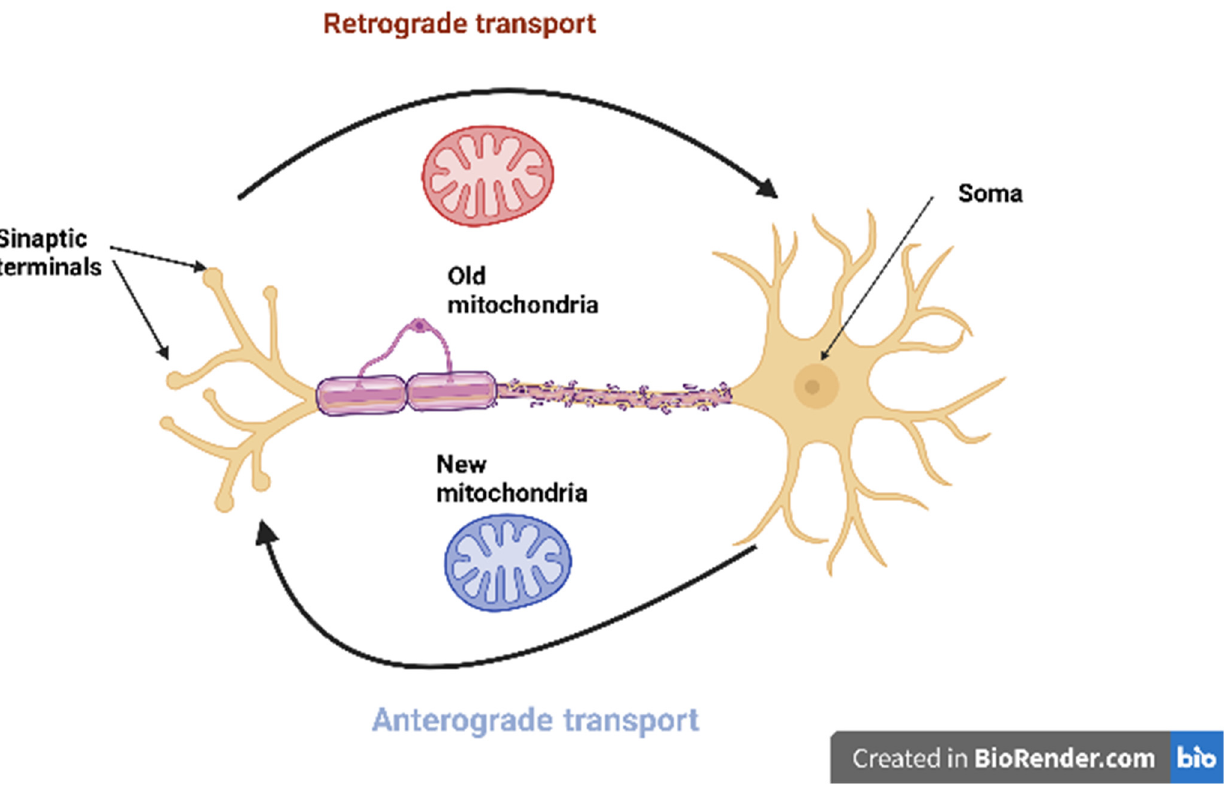
Figure 1. The general scheme of mitochondrial transport in neurons.